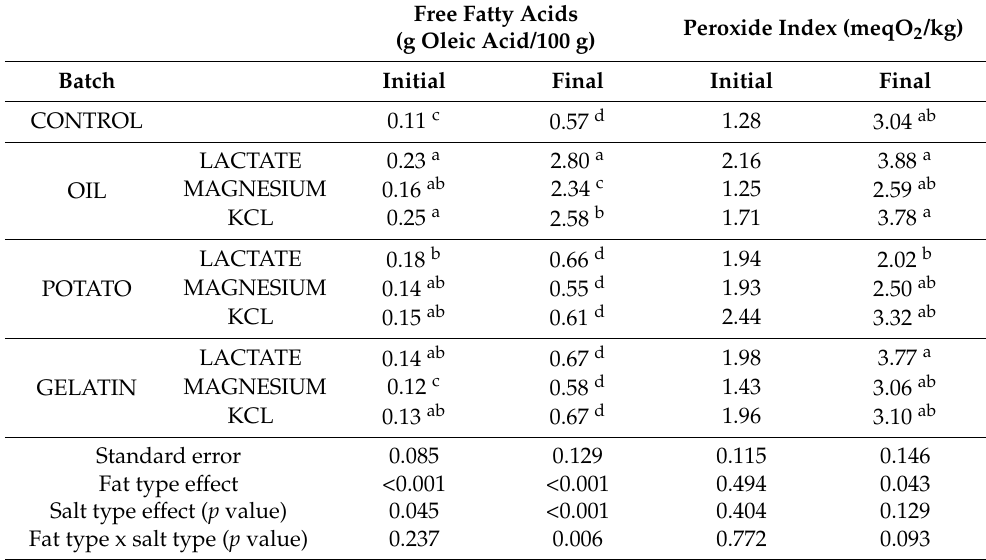
Table 3. The means and standard error for free fatty acid content and for peroxide value of 10 experimental batches of dry-fermented sausages and the p values for studied effects (fat type and salt